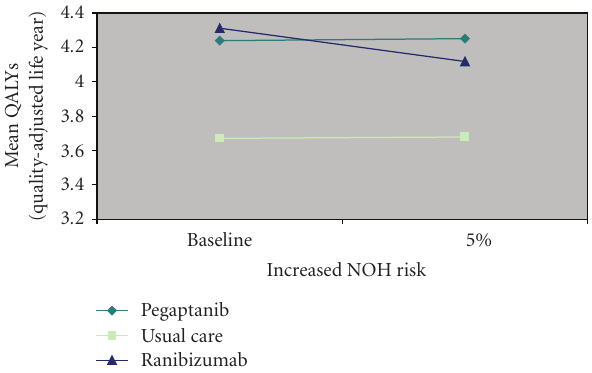
Figure 4: Net health benefits accruing to patients with neovascular age-related macular degeneration when using vascular endothelial growth factor inhibitors according to annual risk of a nonocular hemorrhagic (NOH)